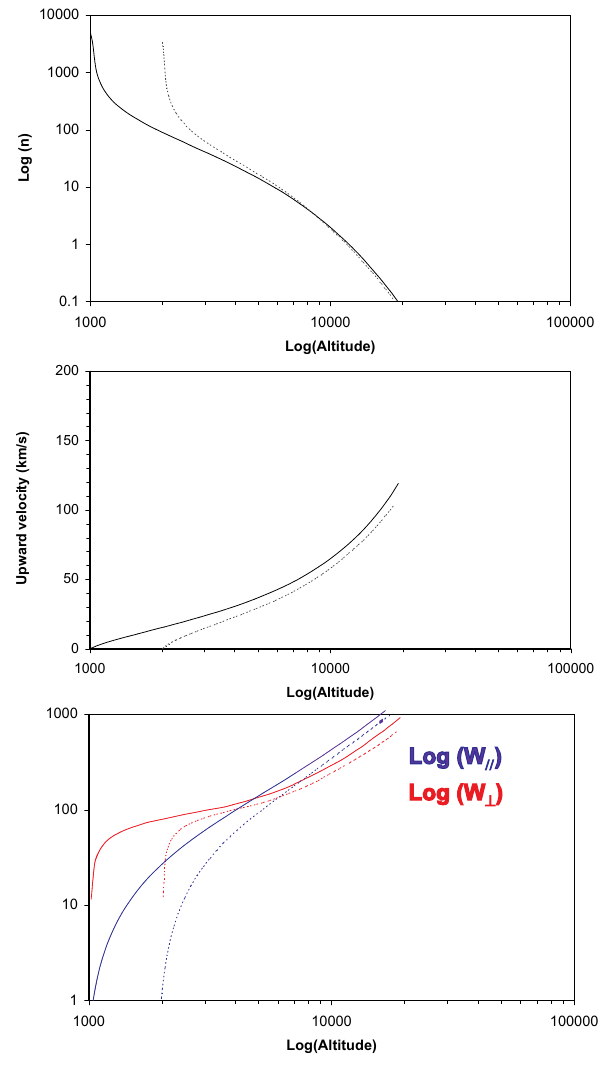
Fig. 7. Evolution of O + moments along the poleward heating boundary: ( a ) density, ( b ) upward mean velocity, ( c ) perpendic- ular (red) and parallel (blue) mean energies. The solid and dashed curves are associated with a source distribution injected at an alti- tude of 1000 and 2000km,